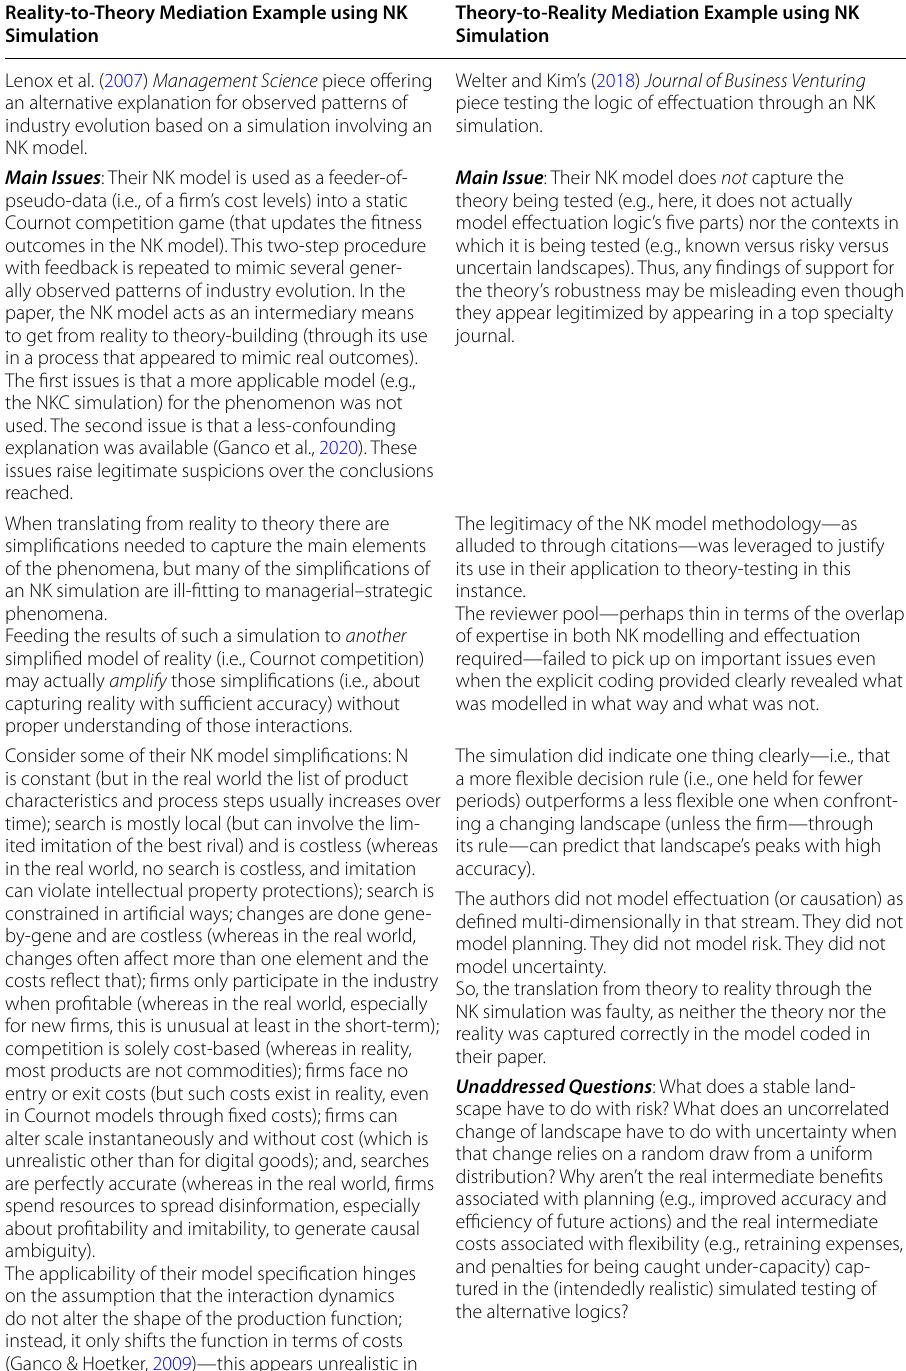
Table 2 Analysis of examples of how the NK approach is a poor mediator in either direction Reality-to-Theory Mediation Example using NK